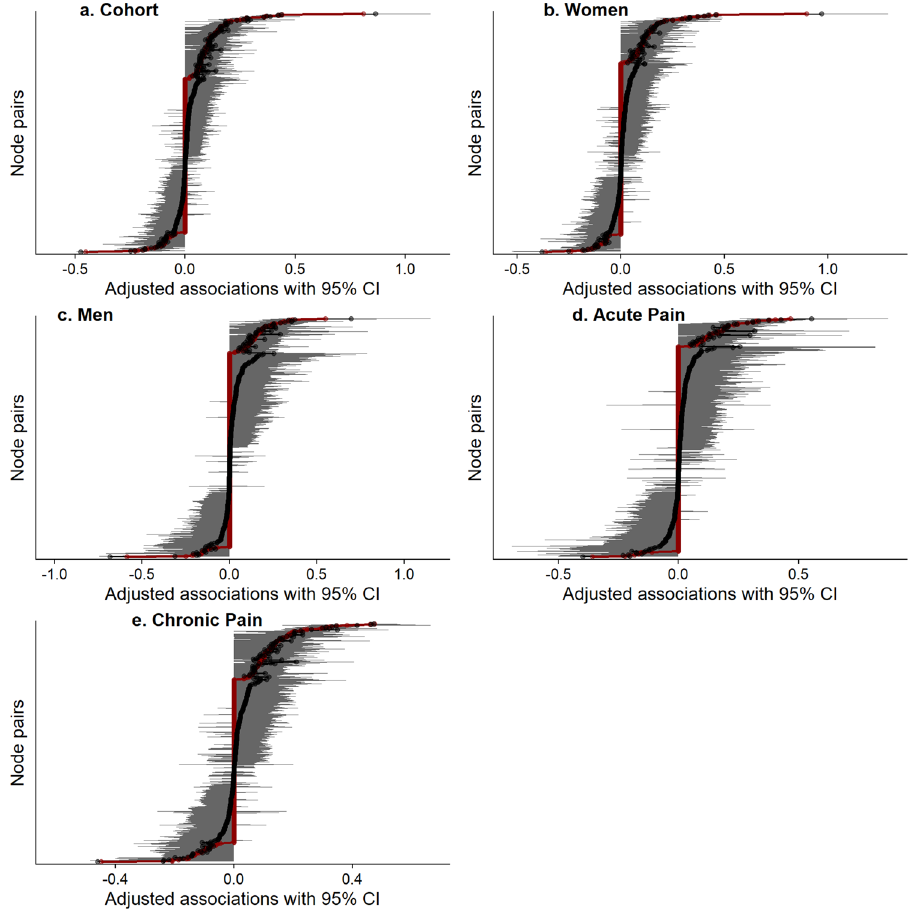
Figure 5. Estimated and observed mean of pairwise associations. A qualitative overview of the estimated (grey) and observed mean (red) with 95% CI of pairwise associations across different node pairs. The names of the node pairs (i.e. Y axis labels and ticks) are removed to avoid visual clutter. Exact values are reported in the Supplementary